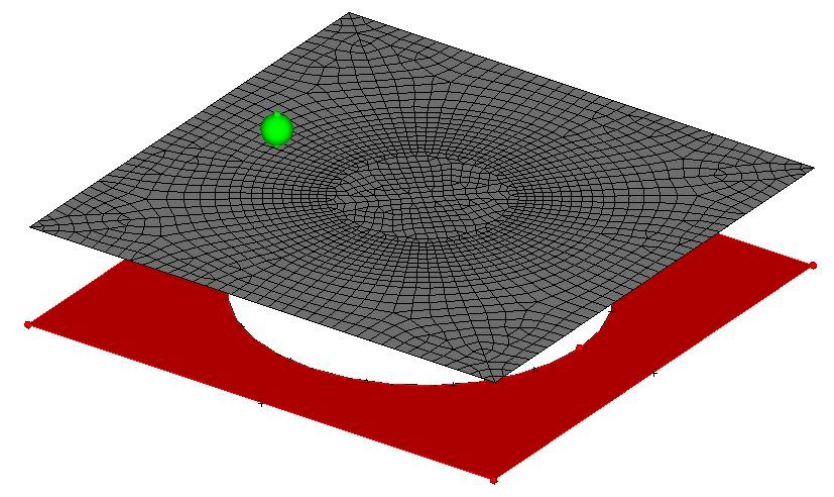
Figure 3. FE model for the SPIF analysis.